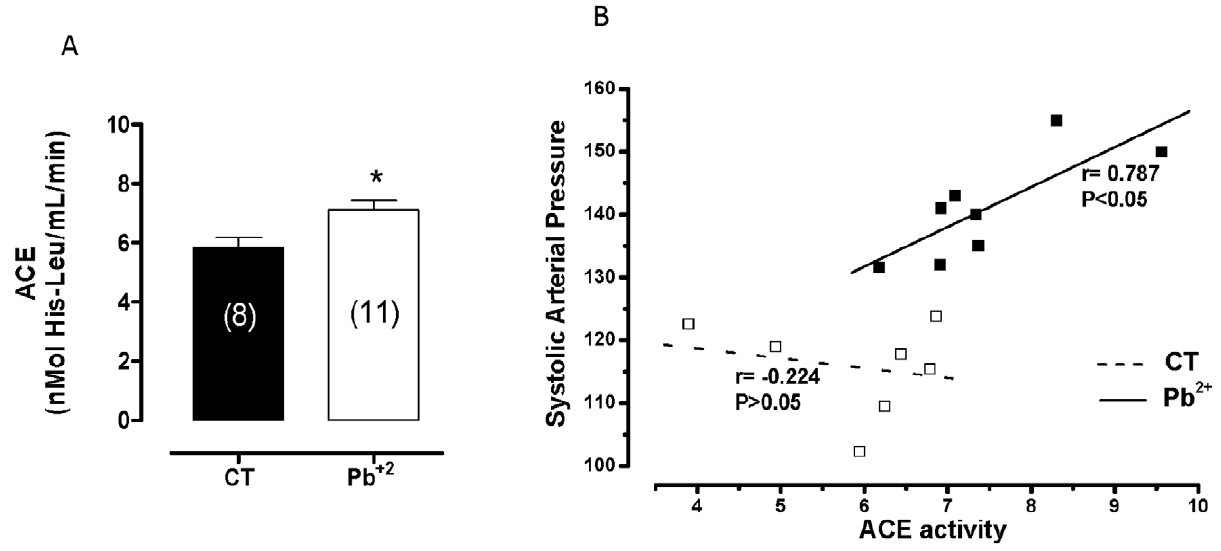
Figure 4. Angiotensin converting enzyme (ACE) activity (nmol His-Leu/min) in plasma; correlation between systolic arterial blood pressure and ACE activity (nmol His-Leu/min) in plasma of control and lead-treated rats (r=0.787, P , 0.05). *P , 0.05 by Student’s t- test. Number of animals used is indicated in parentheses. doi:10.1371/journal.pone.0017117.g004 PLoS ONE |